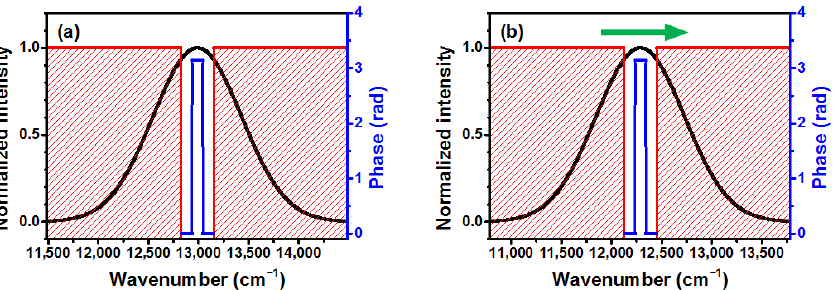
Figure 3. Schematic of the modulations of ( a ) pump and ( b ) Stokes laser spectrum. The window of the pump laser is fixed, while that of the Stokes laser scans from low to high frequency, as shown by the green arrow.